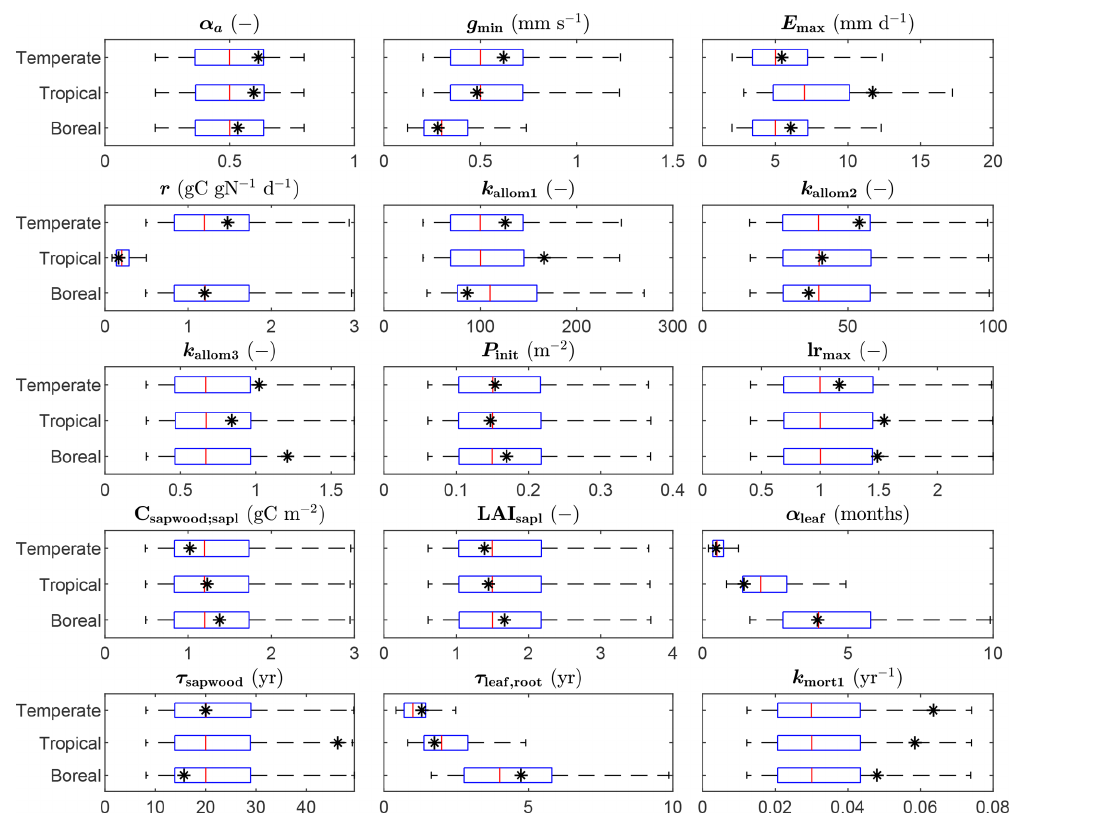
Figure 3. Prior distributions and estimated values of the FPFT parameters estimated in the calibration. The box plots indicate the 5th and 95th percentiles (whiskers), the median (red line), and 25th and 75th percentiles (box) or the priors. The final parameter estimate is indicated by the asterisk ( ∗ ). See Table 1 for an explanation of the